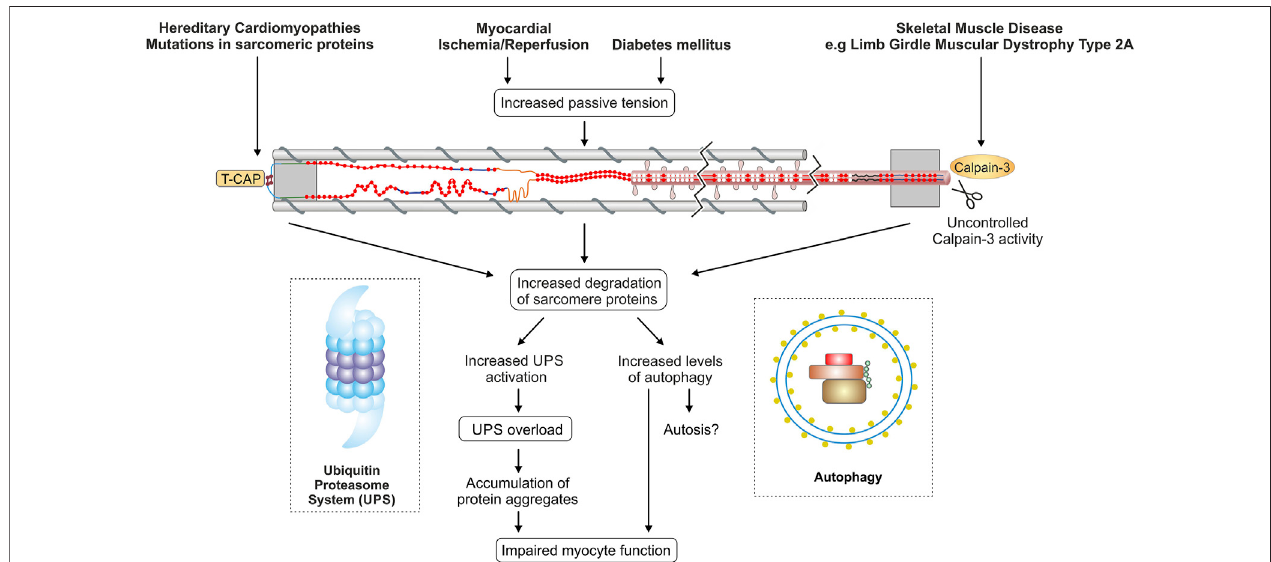
FIGURE 4 | Titin and protein quality control in different disease settings. The fi gure summarizes currently discussed mechanisms of disturbed PQC affecting titin in cardiac and skeletal muscle diseases. TCAP, telethonin/titin-cap.